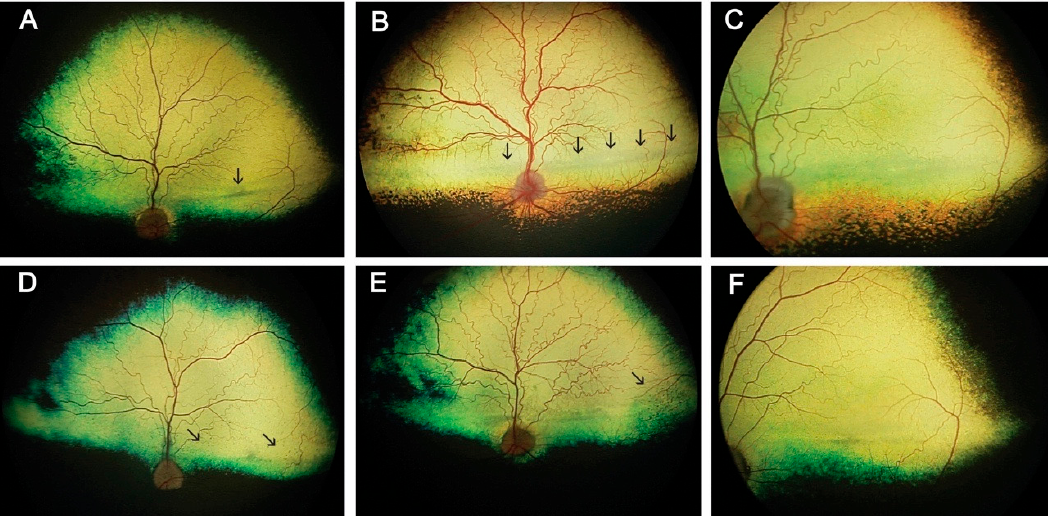
Figure 1. Examples of fundus lesions in the Rpe65-deficient dog. ( A ). Tapetal hyper-reflectivity at the area centralis (arrow) 24 months of age. ( B ). Tapetal hypo-reflectivity along the visual streak (arrows) 39 months of age. ( C ). Higher magnification view of the changes in tapetal reflectivity in a dog 47 months of age. ( D ). Dark foci scattered across tapetal fundus (arrows 42 months of age). ( E ). A region of dark foci at the lateral corner of the tapetal fundus (arrows) in a dog 49 months of age. ( F ). Higher magnification view of small pigment foci in the peripheral fundus (56 months of age). The left eye is shown in all images.